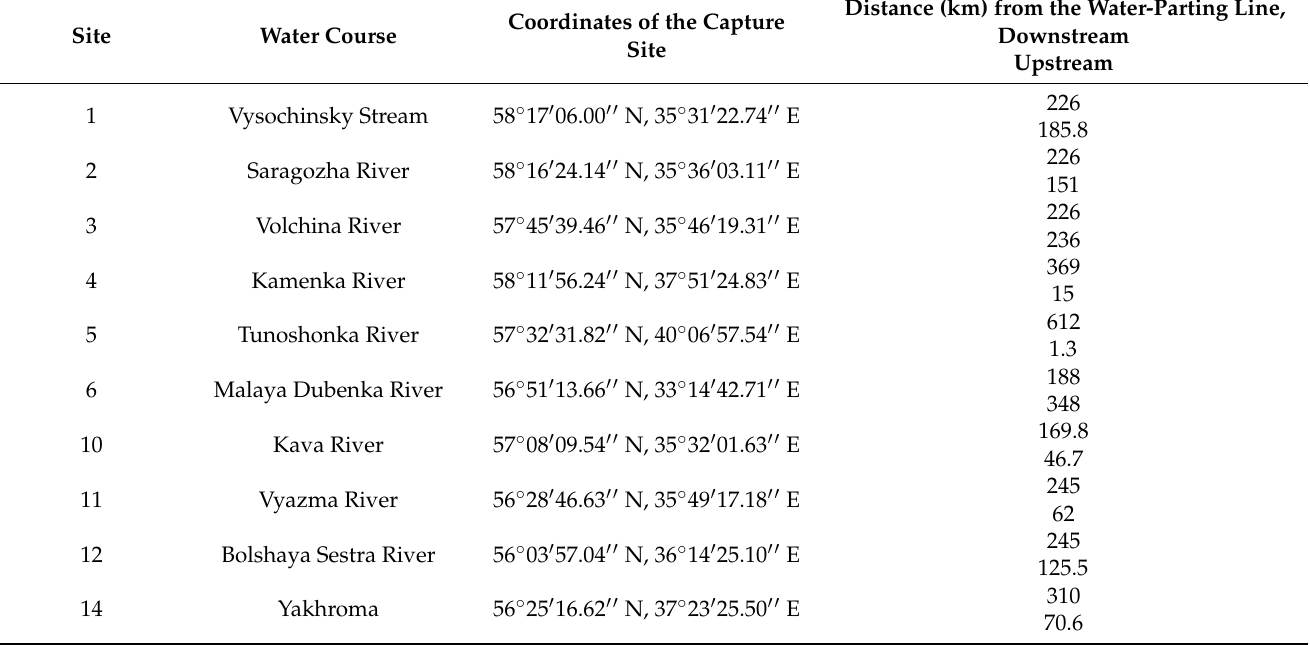
Table 3. Extrapolated distances of dispersal of the European river lamprey Lampetra fluviatilis along the rivers of the Upper Volga